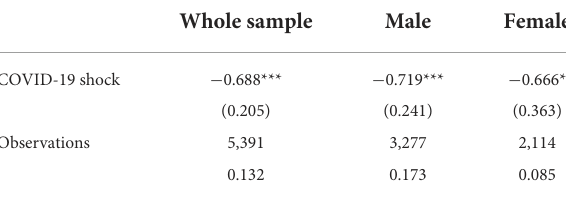
TABLE 7 Robustness test (OLS method).